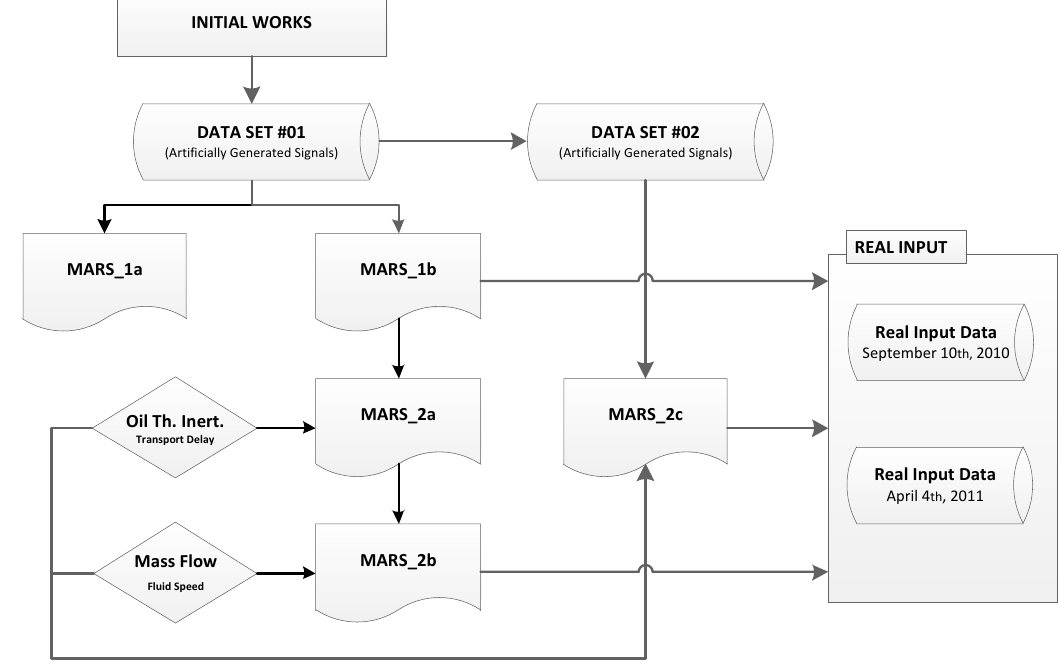
Figure 4. Evolution of the modeling process.